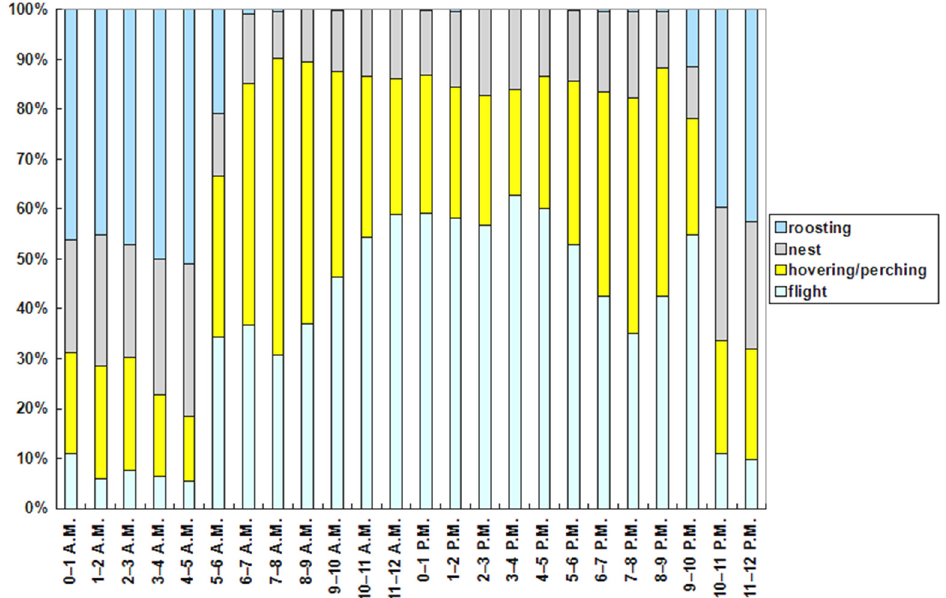
Figure 7. Ethogram of the tracked red-footed falcons on an hourly basis (local time).